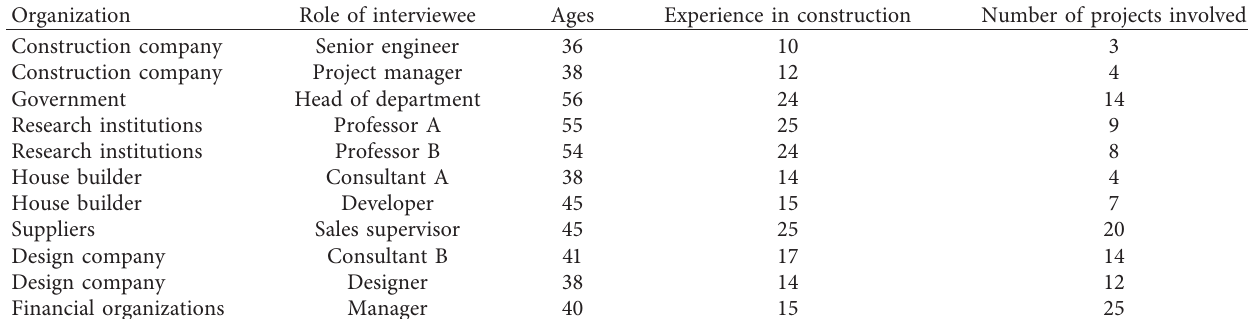
Figure 4: Main research framework. Table 2: The roles of experts participating in the